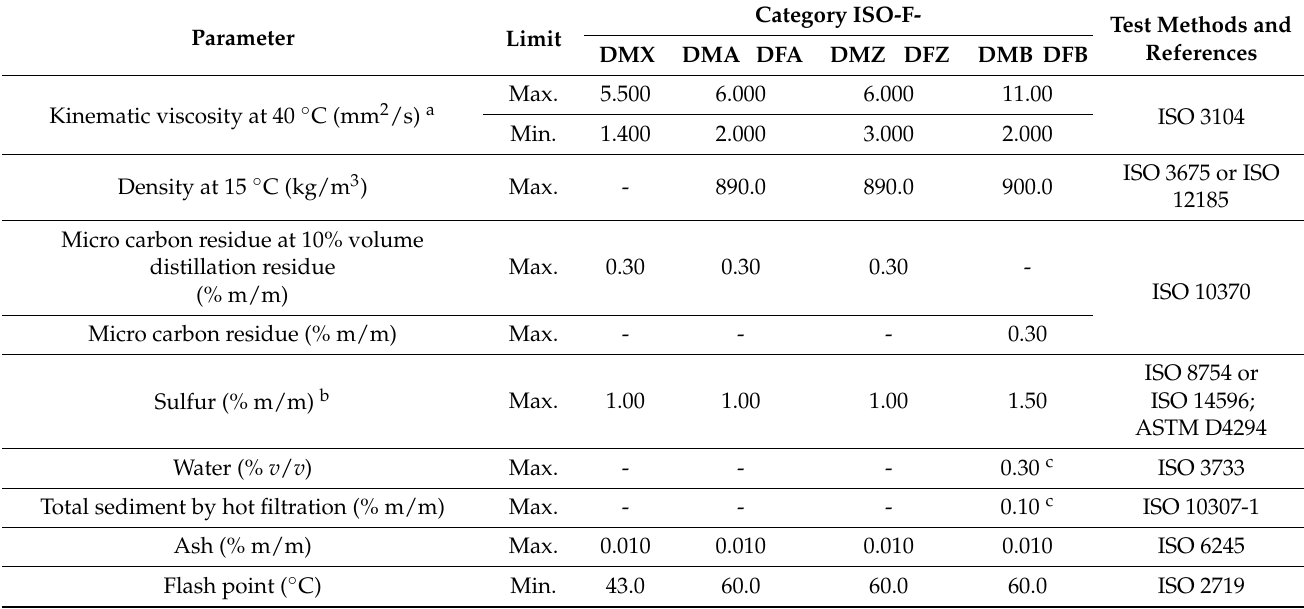
Table A2. Characteristics of Marine Distillate Fuels in Accordance with ISO 8217:2017